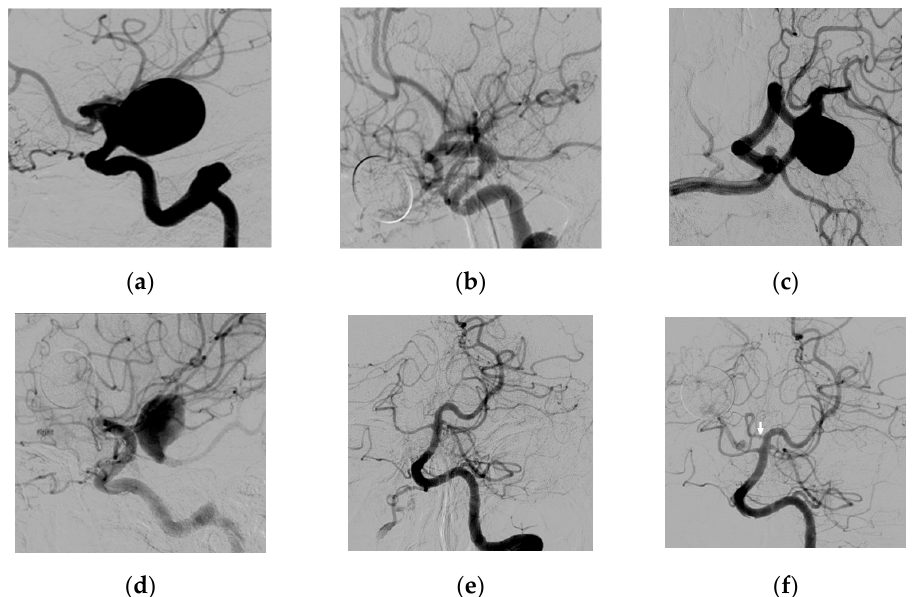
Figure 1. Images of a middle-aged patient with bilateral PComA aneurysms and full fetal type PCA configuration on the right side: ( a ) Lateral angiographic left ICA injection before treatment; ( b ) Six months follow-up DSA showing complete occlusion of the left PComA aneurysm; ( c ) Lateral angiographic right ICA injection before treatment; ( d ) Six months follow-up DSA showing treatment failure of the right PComA; ( e ) Left vertebral artery AP injection showing full fetal type configuration on the right side; ( f ) Follow-up DSA made 1.5 year after initial FD placement on the right with a now visible P1 segment (indicated by the arrow).